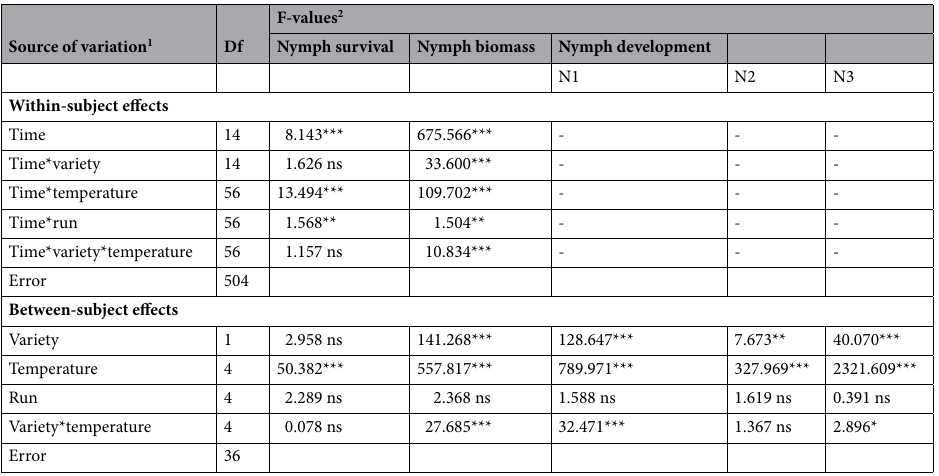
Table 3. Results (F-values) of repeated measures GLMs for nymph survival and biomass over 15 days with results (F-values) of multivariate GLM for nymph development stages (nymphs 2 to 4)(see Fig. 3). 1 Time = time in days as experiment progresses; run = temporal replicate that includes observations for all temperatures conducted across different climate chambers. 2 ns = P > 0.05, * = P ≤ 0.05, ** P ≤ 0.01, *** P ≤